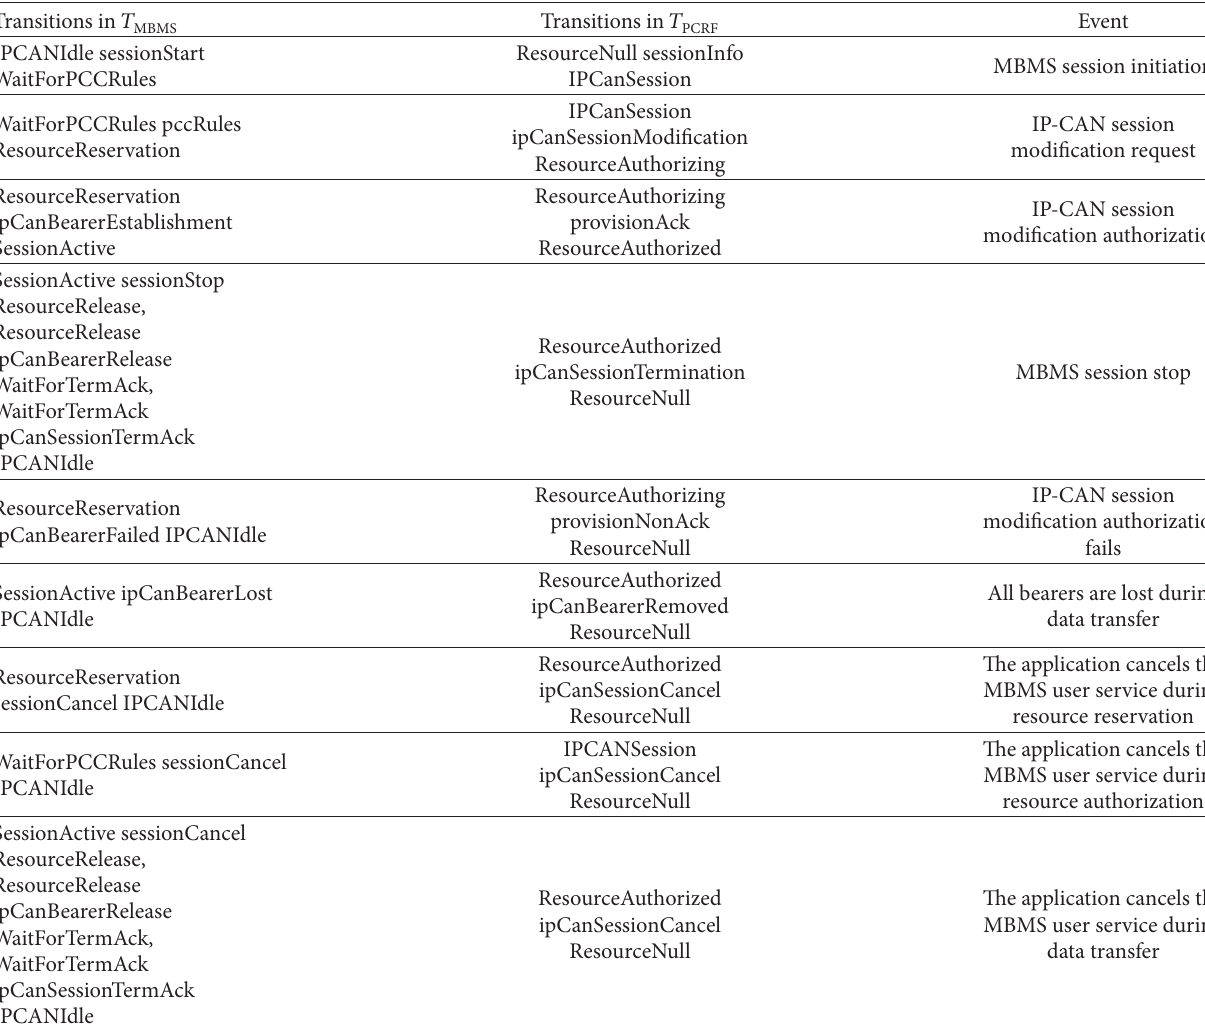
Table 1: Functional mapping between transitions of 𝑇 MBMS and 𝑇 PCRF